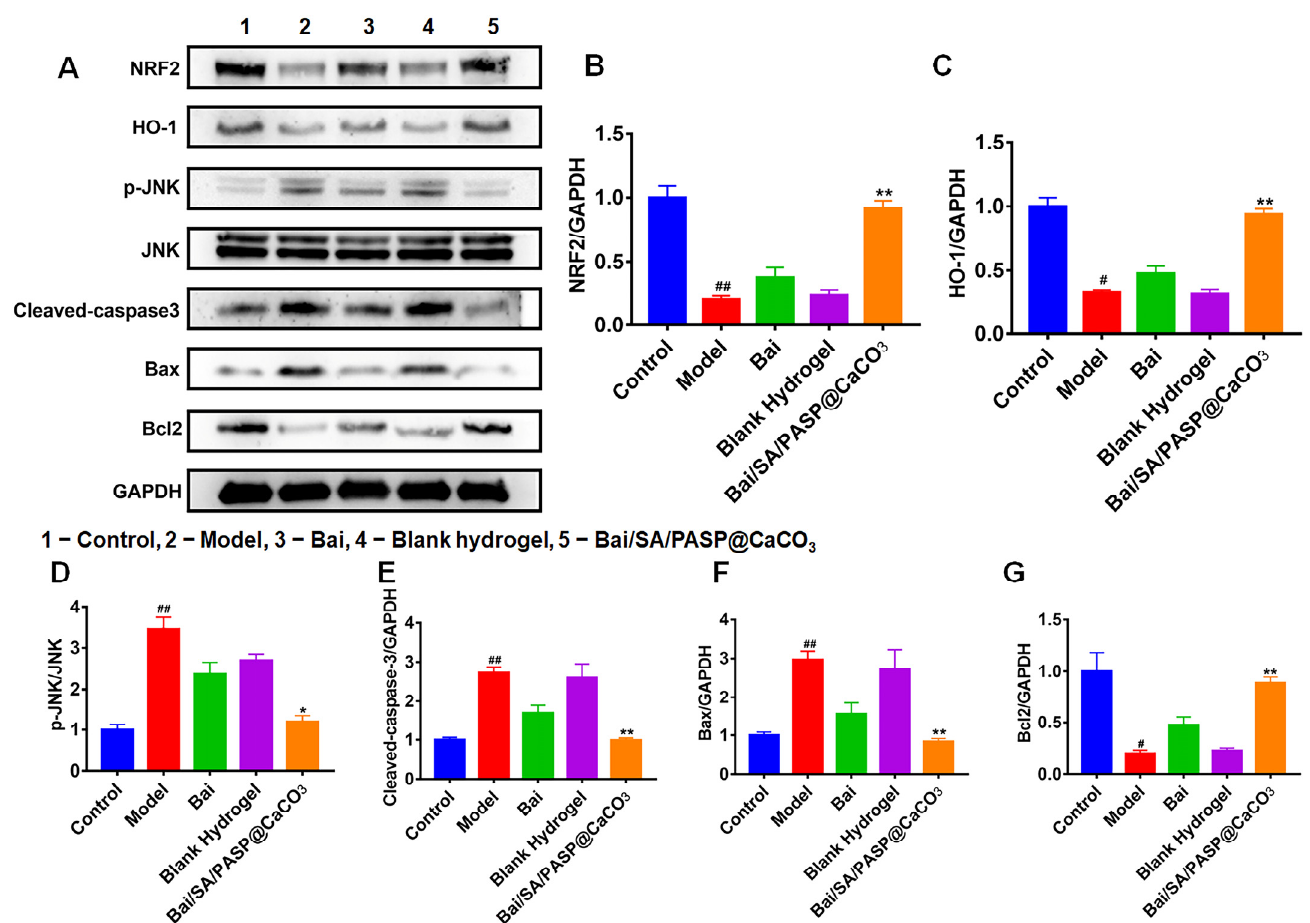
Figure 7. ( A ) Expressions of NRF2/HO-1 signaling-related proteins in rat stomach tissues after being treated with different therapeutic agents. Quantitative analysis of NRF2 ( B ), HO-1 ( C ), p-JNK ( D ), Cleaved-caspase-3 ( E ), Bax ( F ), and Bcl2 ( G ) by Image J, according to Section A. Significant difference from the control group: # p < 0.05, ## p < 0.01. Significant differences from the model group: * p < 0.05, ** p < 0.01.